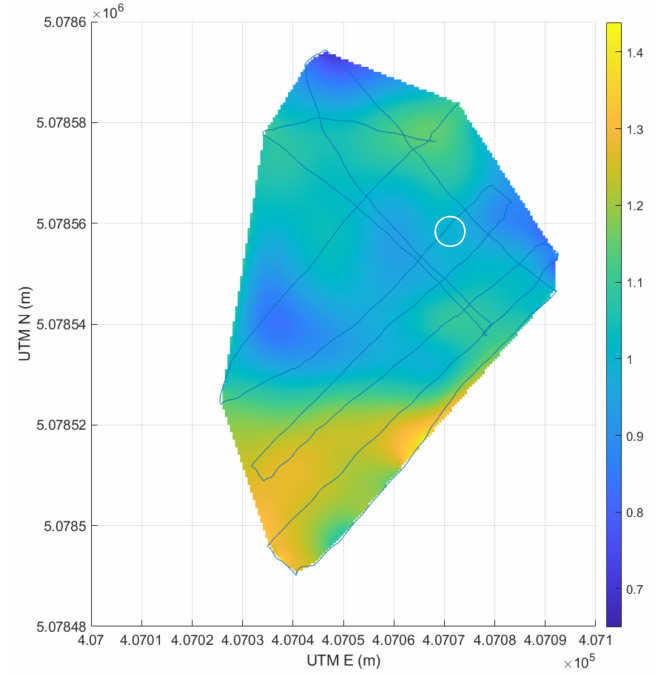
Figure 14. Snow depth distribution of Gressoney test site calculated from GPR pickings of snow– ground interface and data from rangefinder for the air–snow interface. Values in the colour scale are expressed in meters. The circle in the map highlights the monitoring area, where a manual measurement recorded 1 m depth (consistently with the mapped values). Data are slightly smoothed for better